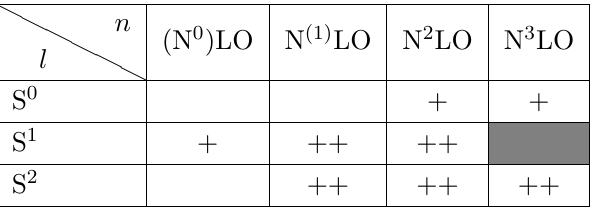
Table 2 . The notation ( n, l ) of sectors was introduced in [48]. The 11 sectors that contribute to the present (3 , 2) one through redefinition of variables. “+” marks sectors that require only position shifts to be fixed, whereas “++” marks sectors that require redefinition of both position and rotational variables to be